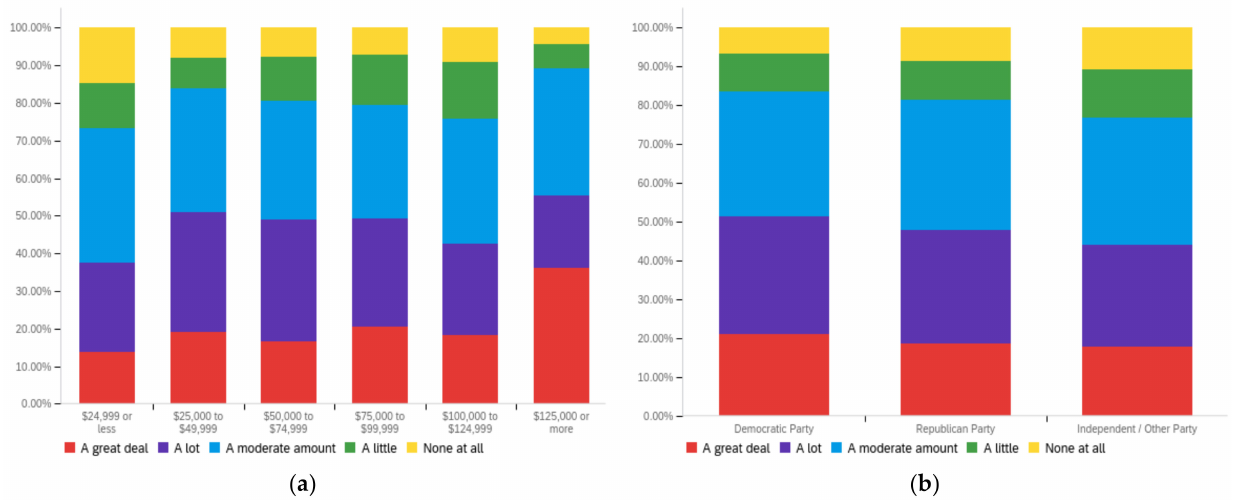
Figure A32. Cont